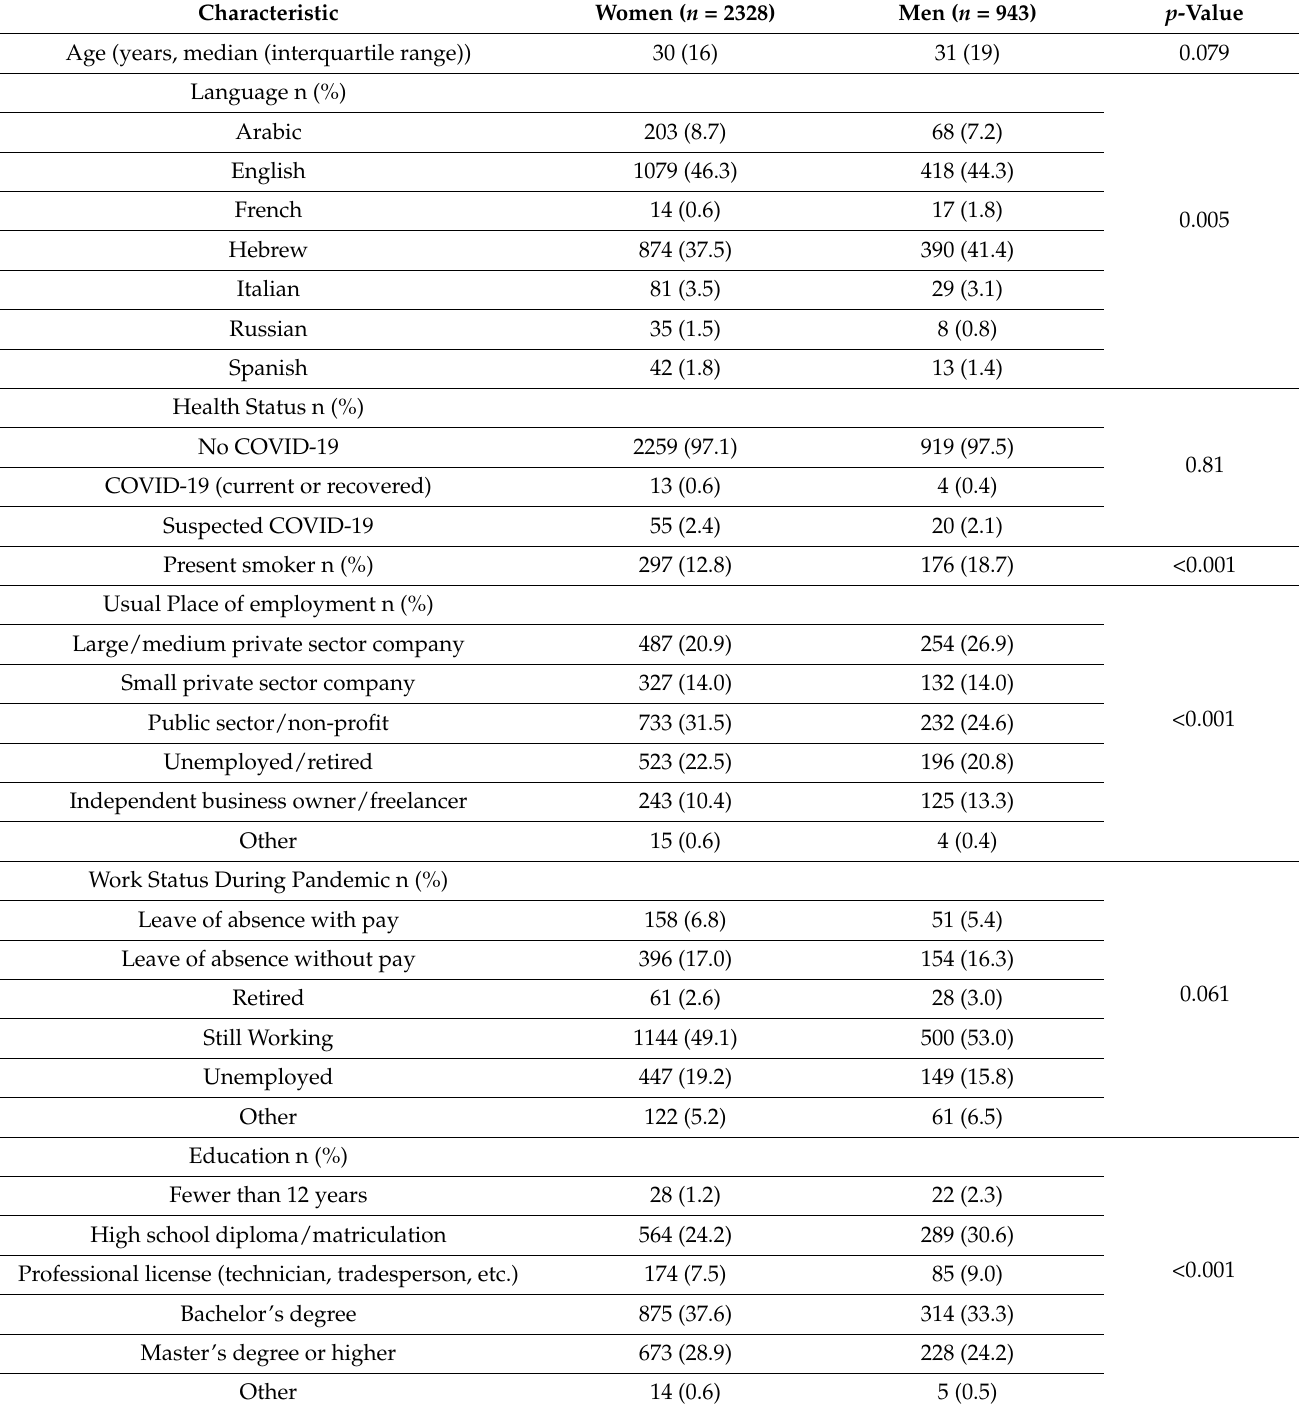
Table 1. Study Population Characteristics by